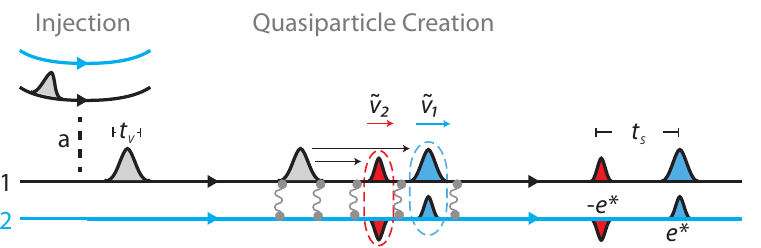
Figure 3: A charge pulse of time duration t is injected into edge mode 1. Due to the interaction v quench, the injected pulse decomposes into a charge and a neutral pulse, propagating with different velocities ˜ v . After the quench, two oppositely and fractionally charged pulses e ∗ are i separated in time by t in edge mode s